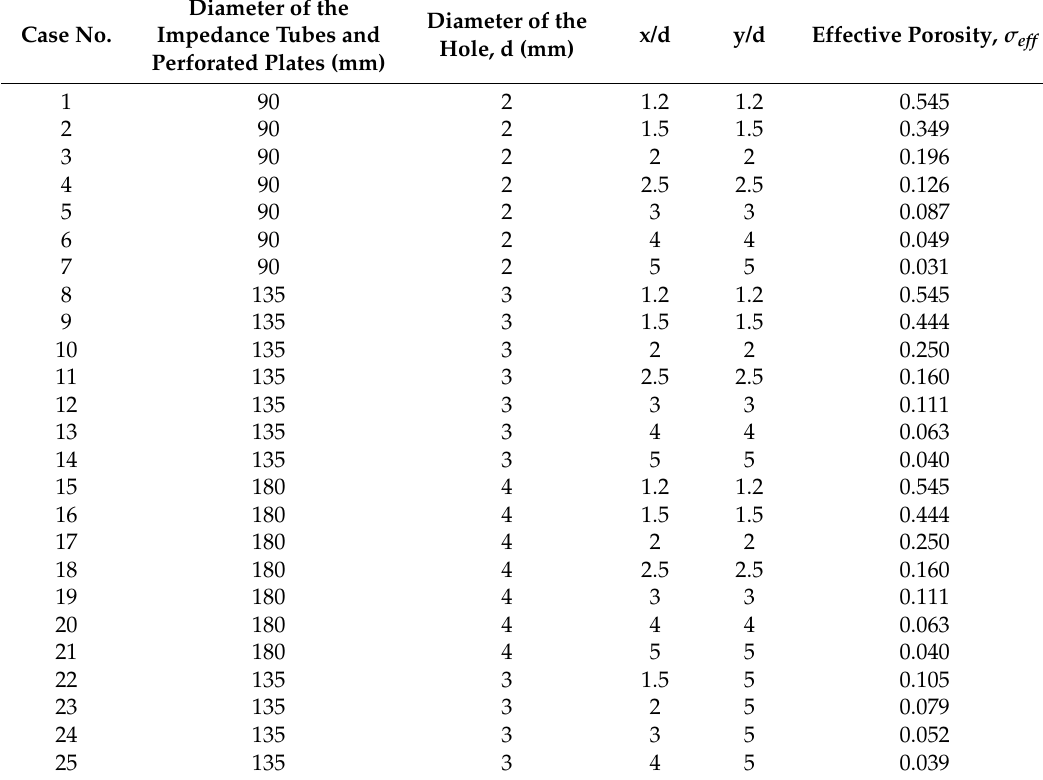
CFD: Abbreviation for “Computational Fluid Dynamics”; x: hole separation distance in the horizontal direction as shown in Figure 4; y: hole separation distance in the vertical direction as shown in Figure 4; σ ef f : effective porosity as defined in Equation